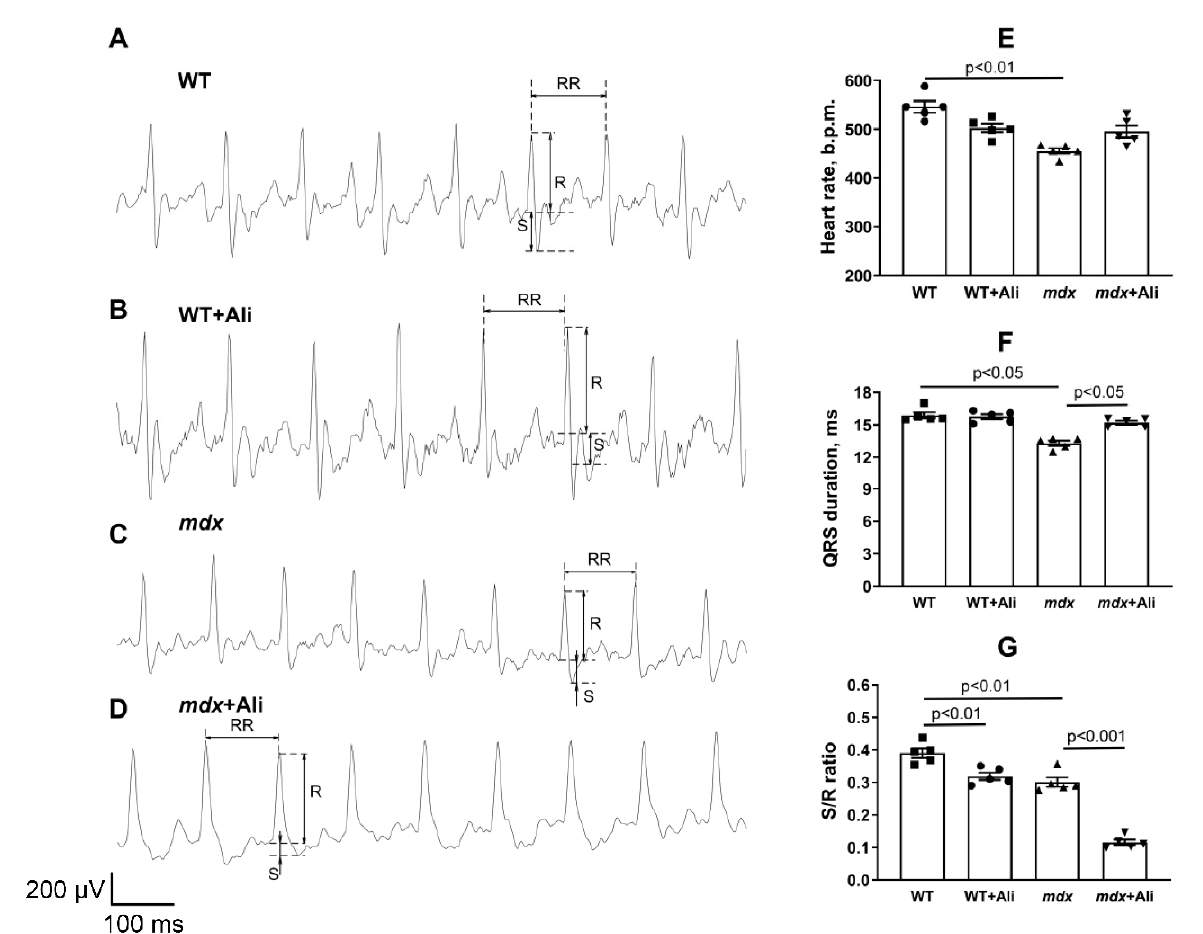
Figure 7. Representative ECG tracings from WT ( A ), WT + Ali ( B ), mdx ( C ), and mdx + Ali ( D ) groups of mice. Graphical representation of ECG profiles: heart rate ( E ), QRS duration ( F ), and S/R ratio ( G ). The data are presented as means ± SEM ( n = 5).